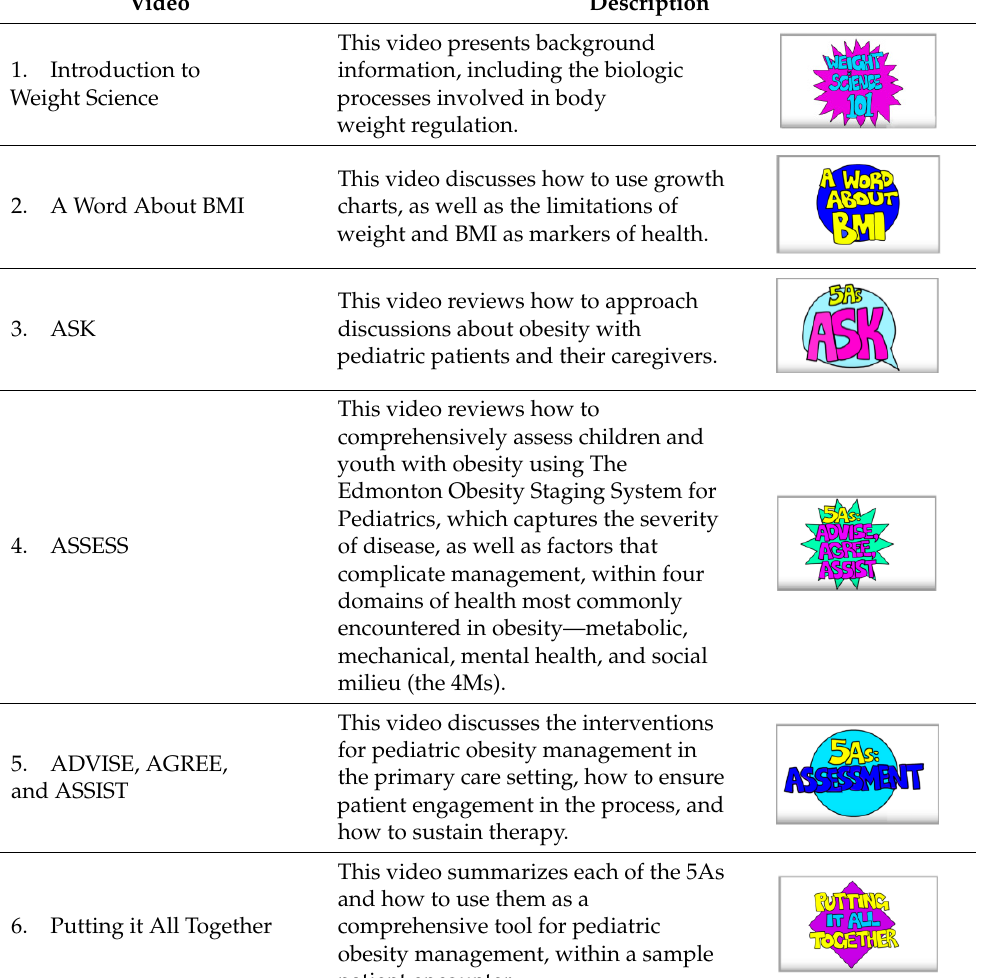
Table 1. Description of videos in the toolkit.